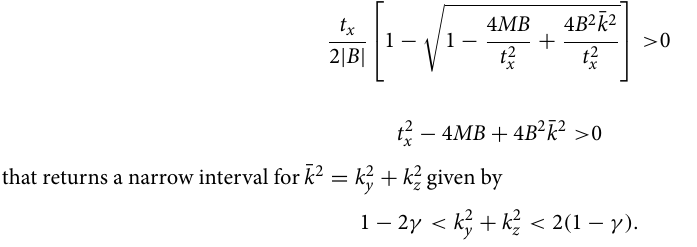
Figure 1. Anisotropic bands dispersion at the critical point γ linear and quadratic band-crossing, respectively 47,48